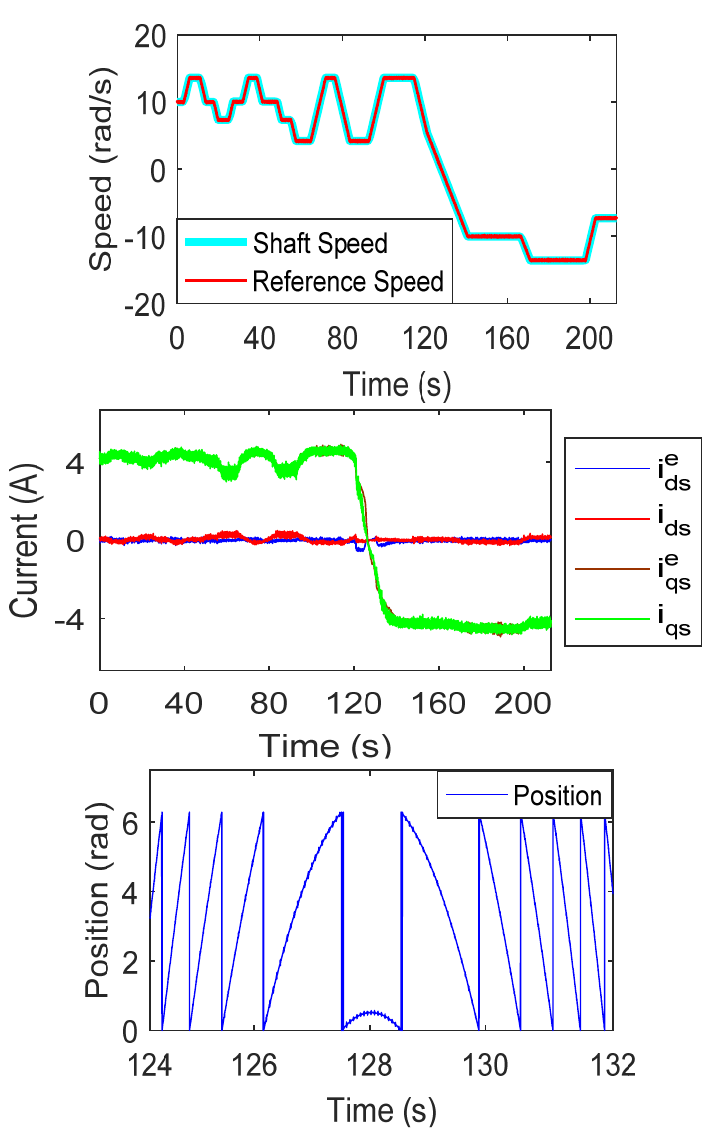
Figure 11. Experimental results for the forward and reverse motoring operations.